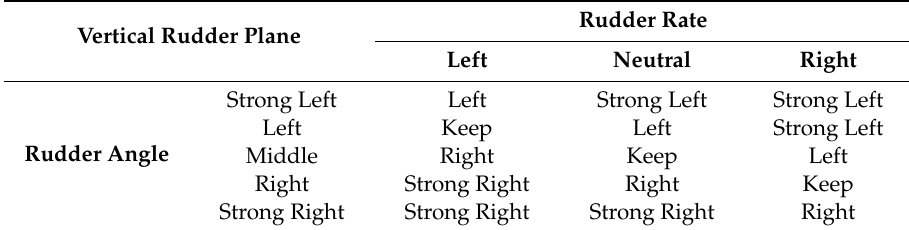
Table 4. Rule base of the vertical rudder plane.